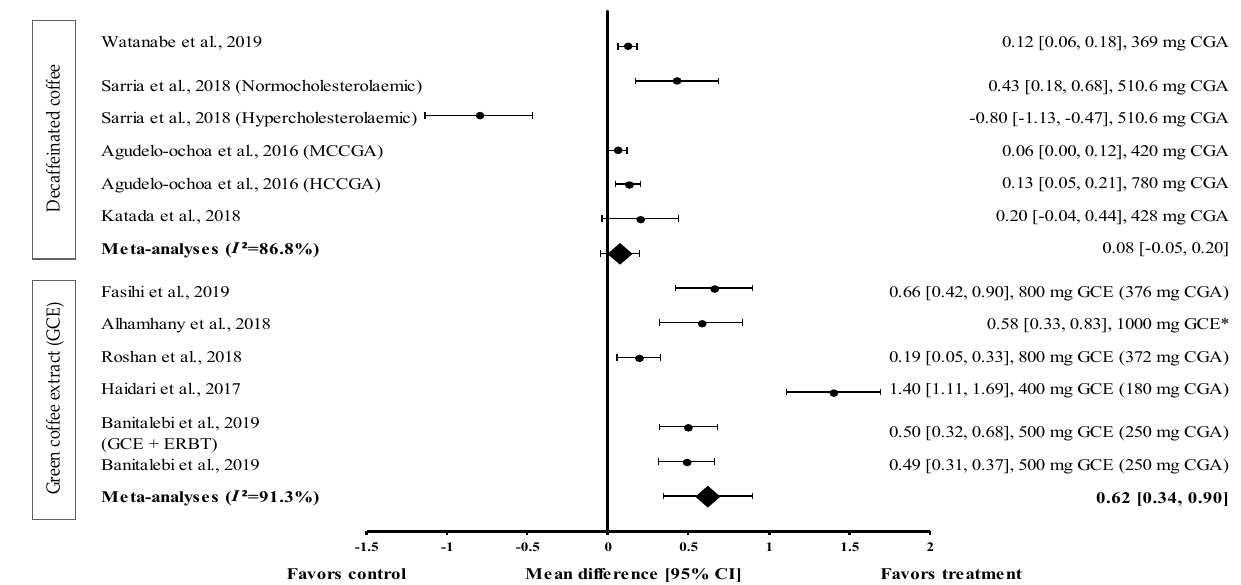
Figure 5. Forest plot showing the effect of decaffeinated coffee and GCE supplements on HDL-c levels, expressed as mean differences between the values obtained in the intervention and control groups. A positive effect size indicates that decaffeinated coffee and GCE supplements increased the HDL-c levels. Meanwhile, a negative effect size indicates that decaffeinated coffee reduced the HDL-c levels. Horizontal lines represent the 95% CIs. Diamonds represent the pooled effect size from the random effect analysis. CGA: chlorogenic acid, CI: confidence interval, GCE: green coffee extract, HCCGA: high CGA content, HDL-c: high-density lipoprotein-cholesterol, MCCGA: medium CGA content. The values ± 0.2, ± 0.5 and ± 0.8, represent small, medium, and large effect sizes, respectively. * CGA dose not specified